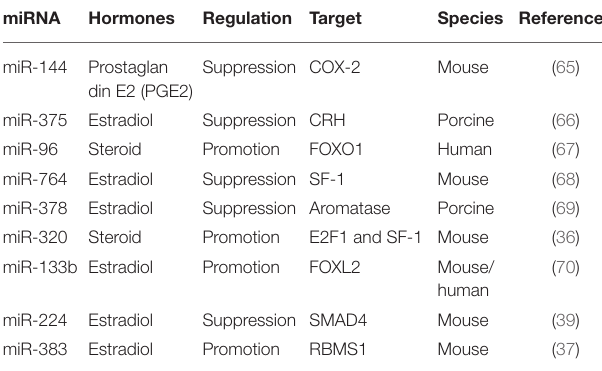
TABLE 1 | GC secretes hormones related